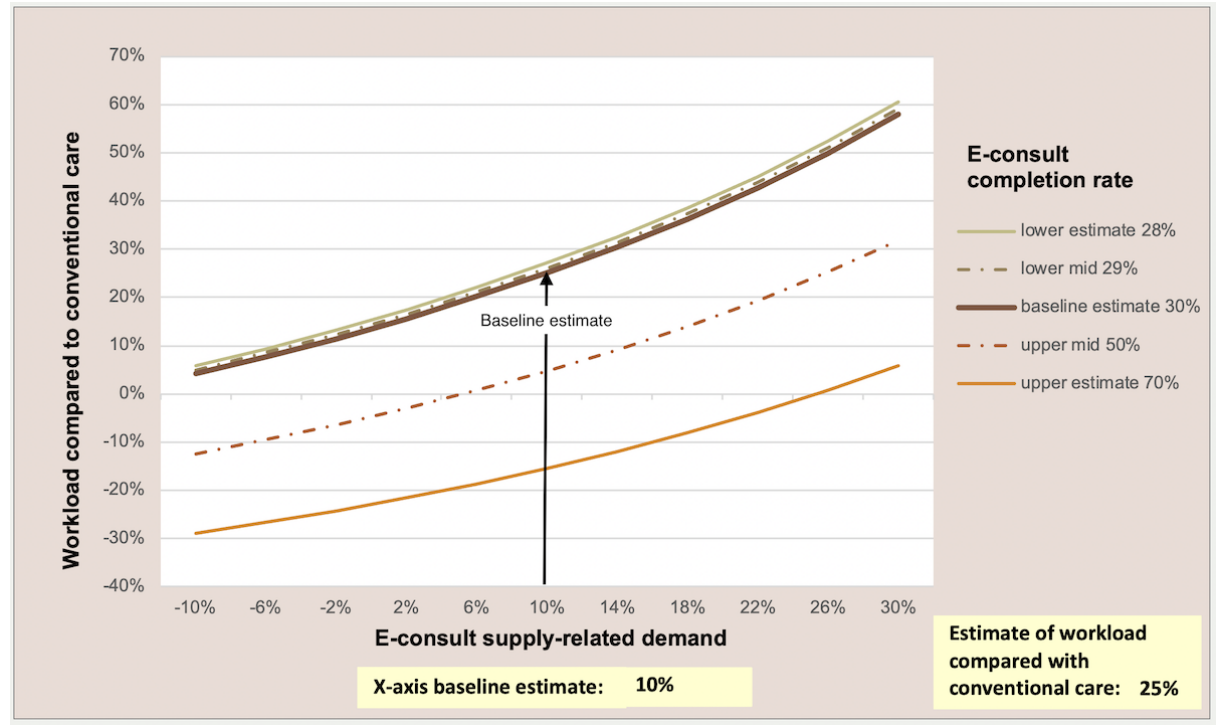
Figure 3. Impact of e-consultations on general practitioner workload: varying supply-related demand and e-consultation completion rate. E-consult: online